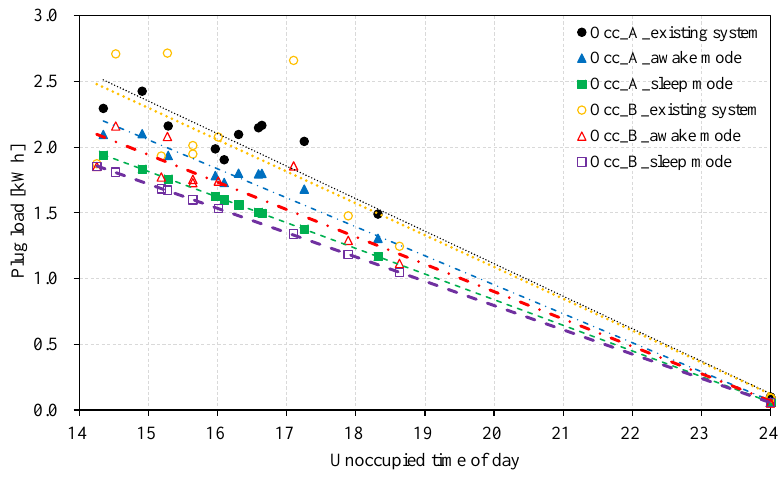
Figure 19. Occupant A, Occupant B, unoccupied time and plug load.